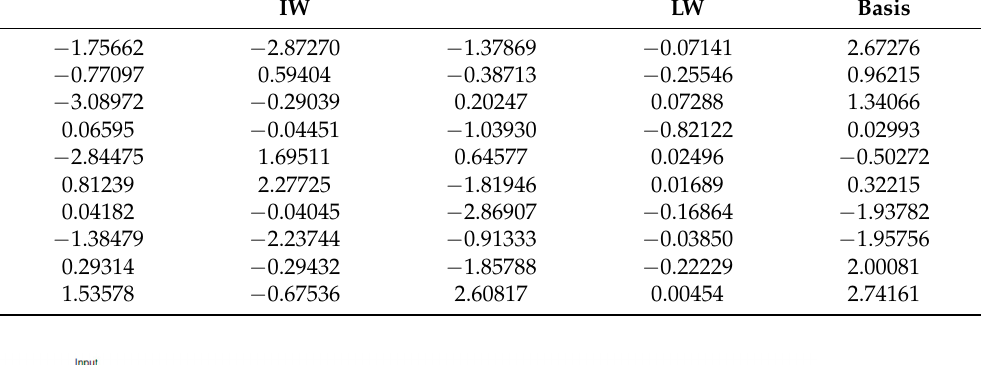
Table 3. The weights and the basis of the trained neural network.